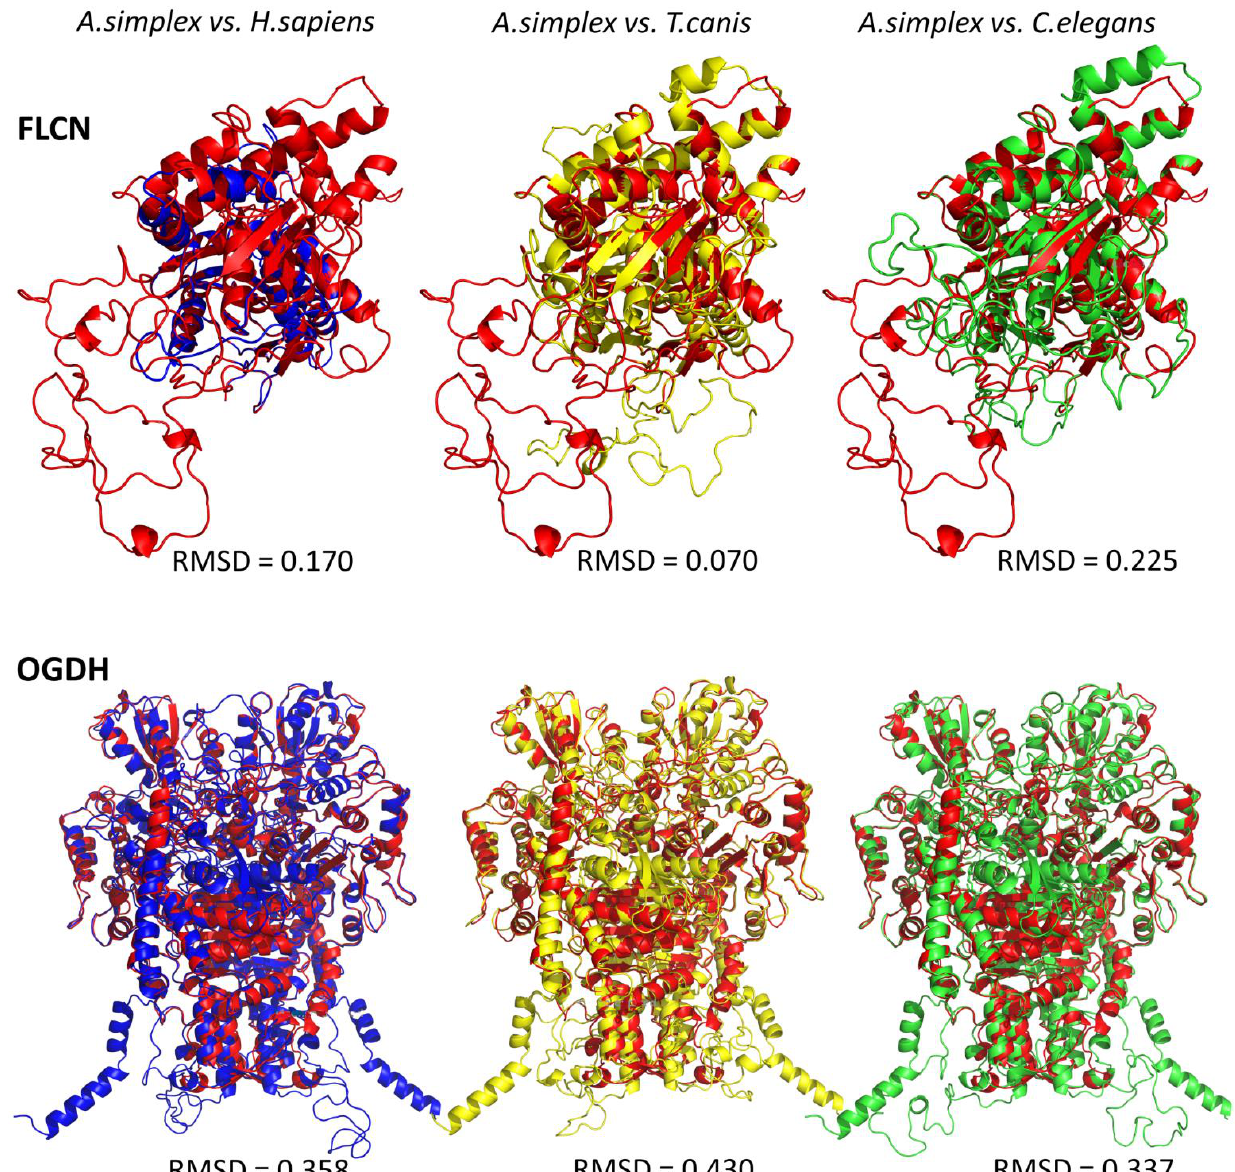
Figure 5. Predicted tertiary structures of A. simplex s. s. oxoglutarate dehydrogenase (OGDH) and folliculin (FLCN). The structures are color-coded (structural alignment) for the respective species: A. simplex s. s.—red, H. sapiens— blue, T. canis— yellow, C. elegans— green. The root mean square A. simplex s. s.—red, H. sapiens —blue, T. canis —yellow, C. elegans —green. The root mean square